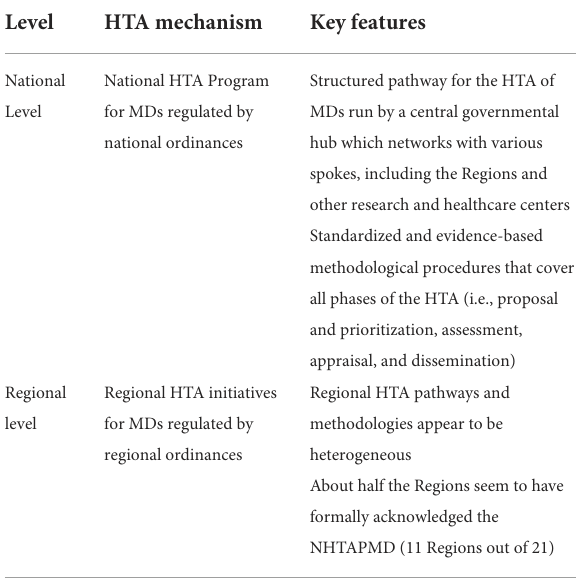
TABLE 1 Italian health technology assessment mechanism for medical devices: national and regional